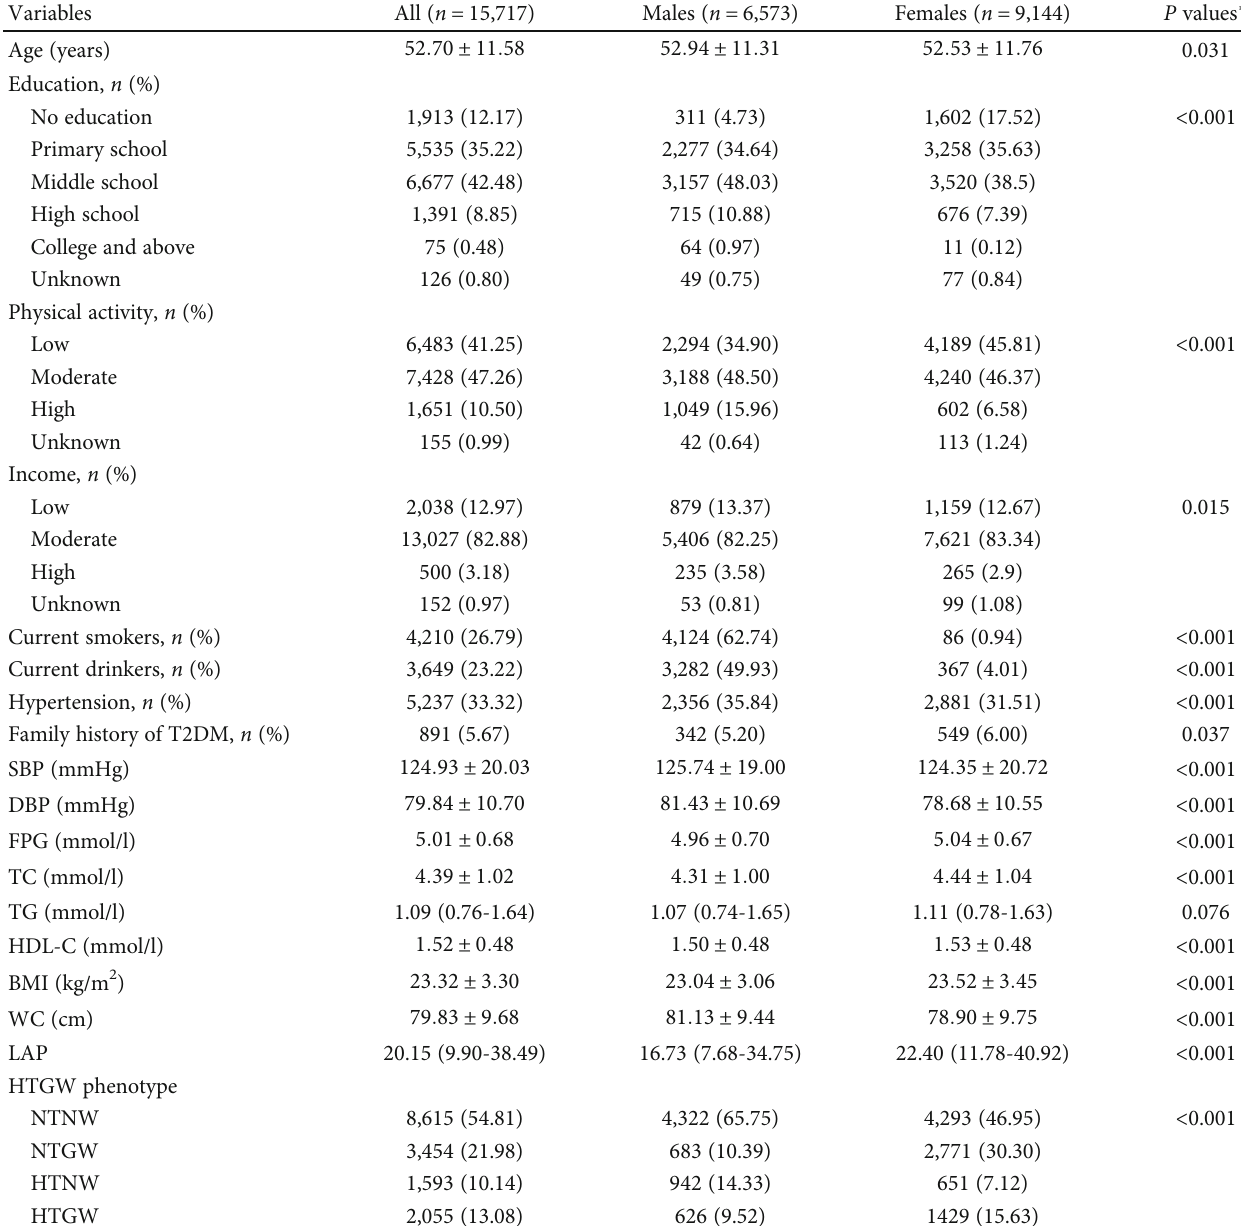
Table 1: Baseline characteristics of study participants by